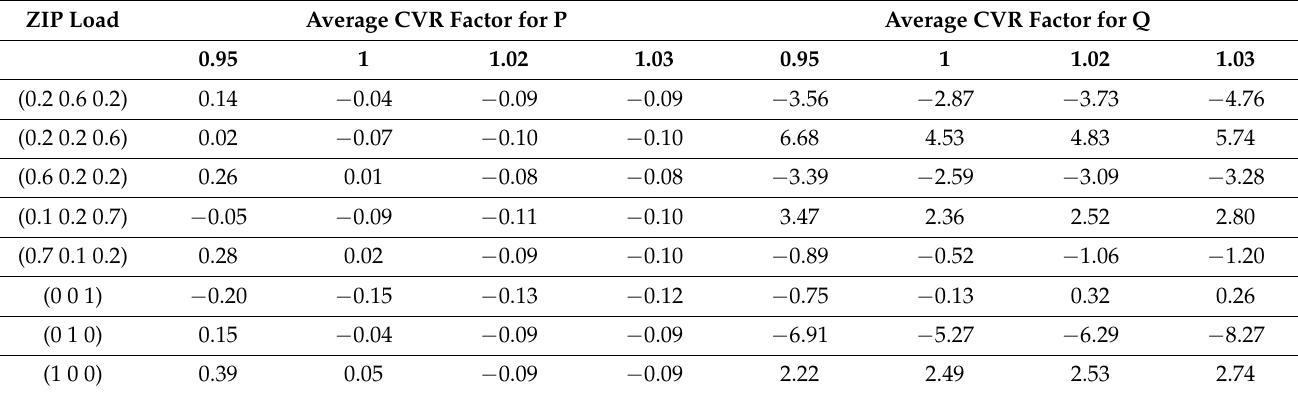
Table 4. Average CVR factor using power captured at substation for case 1.